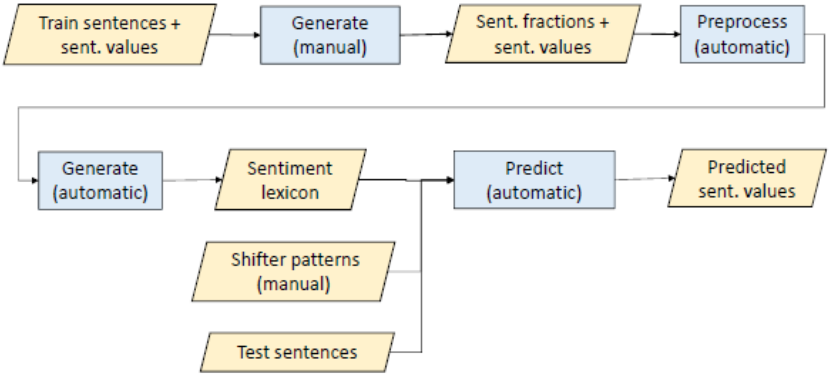
Figure 1. Basic architecture of the SA